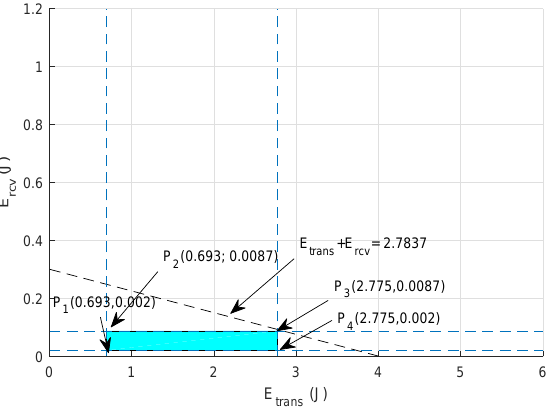
Figure 5. Feasible region: energy